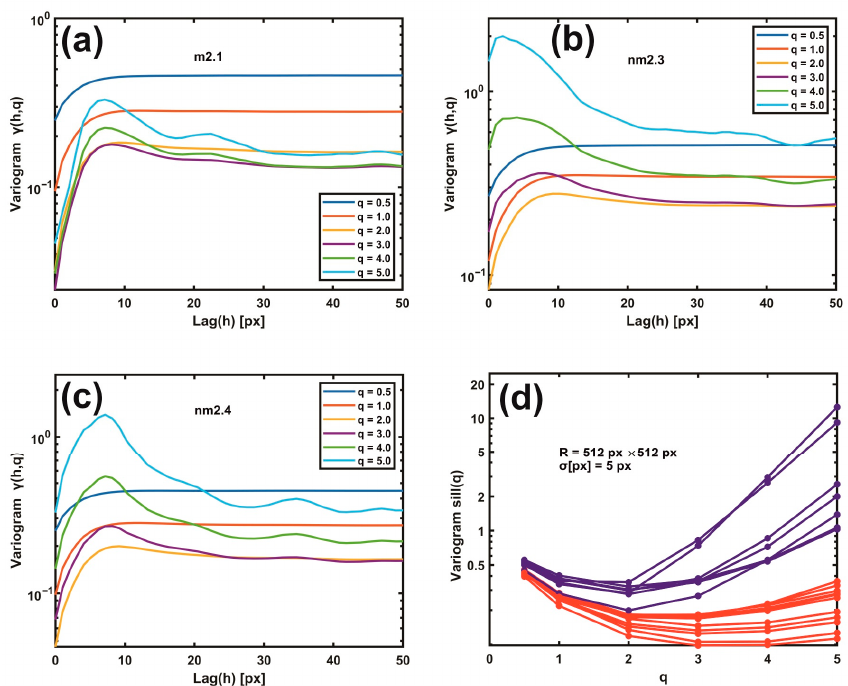
Figure 5. Gaussian filtering residual variograms of different moments q. ( a ) Gaussian filtering residual variograms of q moments from 0.5 to 5.0 for the metastatic tissue m2.1. ( b ) The same as ( a ) for the non-metastatic tissue nm2.3. ( c ) The same as ( b ) for the non-metastatic tissue nm2.4. Threshold criteria for differentiating metastatic and non-metastatic tissues, Figure 4, do not function for the sample nm2.4. ( d ) Gaussian filtering residual variograms of higher moments upsurge the differentiation between metastatic (red) and non-metastatic (blue) groups of lines. For higher moments than two, the nm2.4 tissue sample shows the correct non-metastatic state.